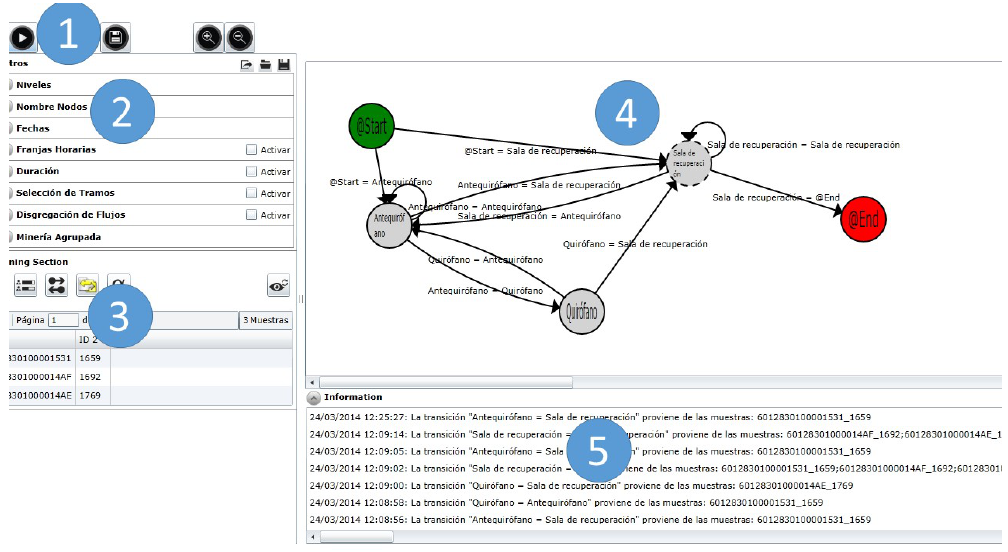
Figure 2. Screenshot of the parallel activity log inference algorithm (PALIA) indoor location system (ILS) suite